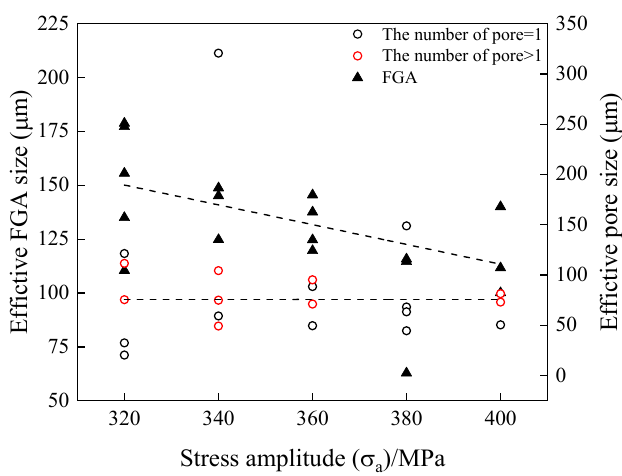
Figure 12. Relationship between the effective sizes of pores and FGA and fatigue life.